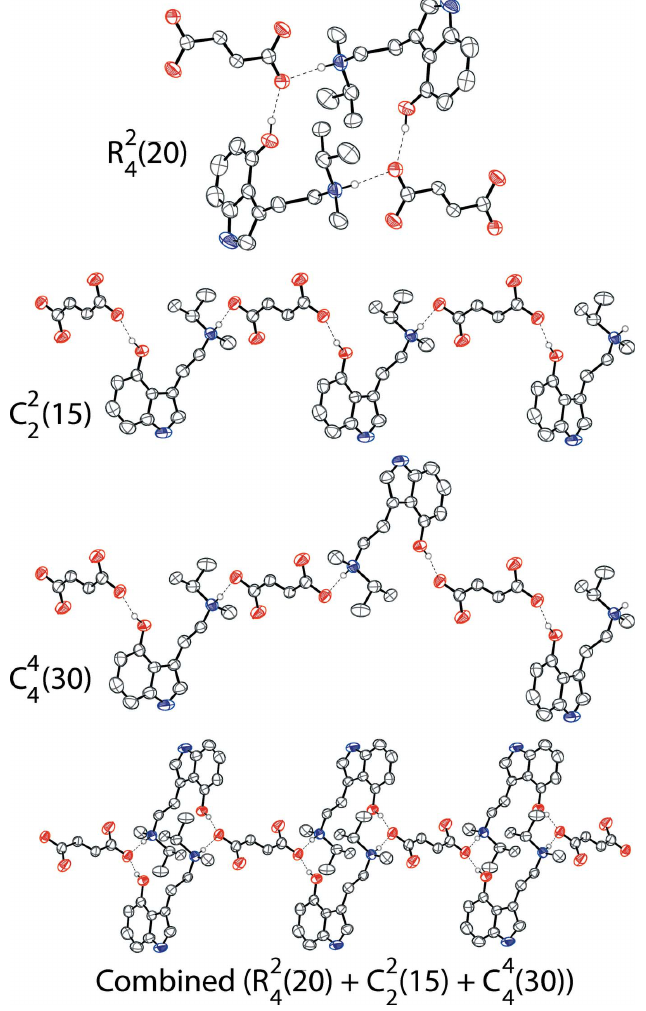
Figure 3 The hydrogen-bonding network along (110), which consists of R 2 rings that are joined together by two parallel C 2 The three components described in graph-set notation and the combined chain are shown. Displacement ellipsoids are drawn at the 50% probability level. Hydrogen atoms not involved in hydrogen bonding are omitted for clarity. Hydrogen bonds are shown as dashed